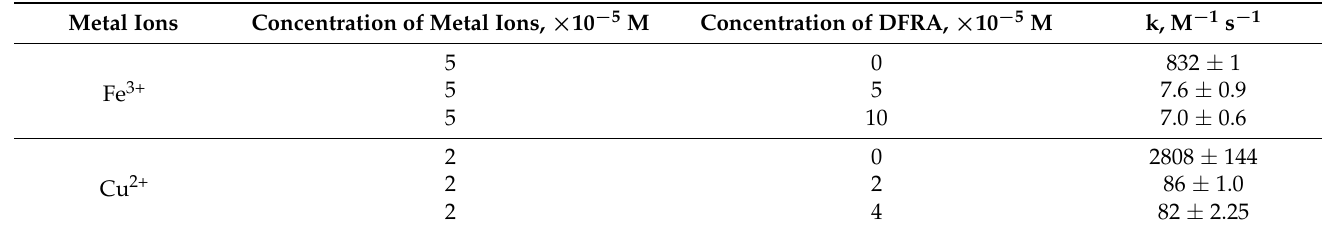
Table 1. The rate constants of the reactions of ascorbic acid (Asc) with Fe 3 + and Cu 2+ ions and their deferasirox (DFRA) complexes calculated from data from Figure 3. The concentration of Asc in both cases was 0.1 mM.